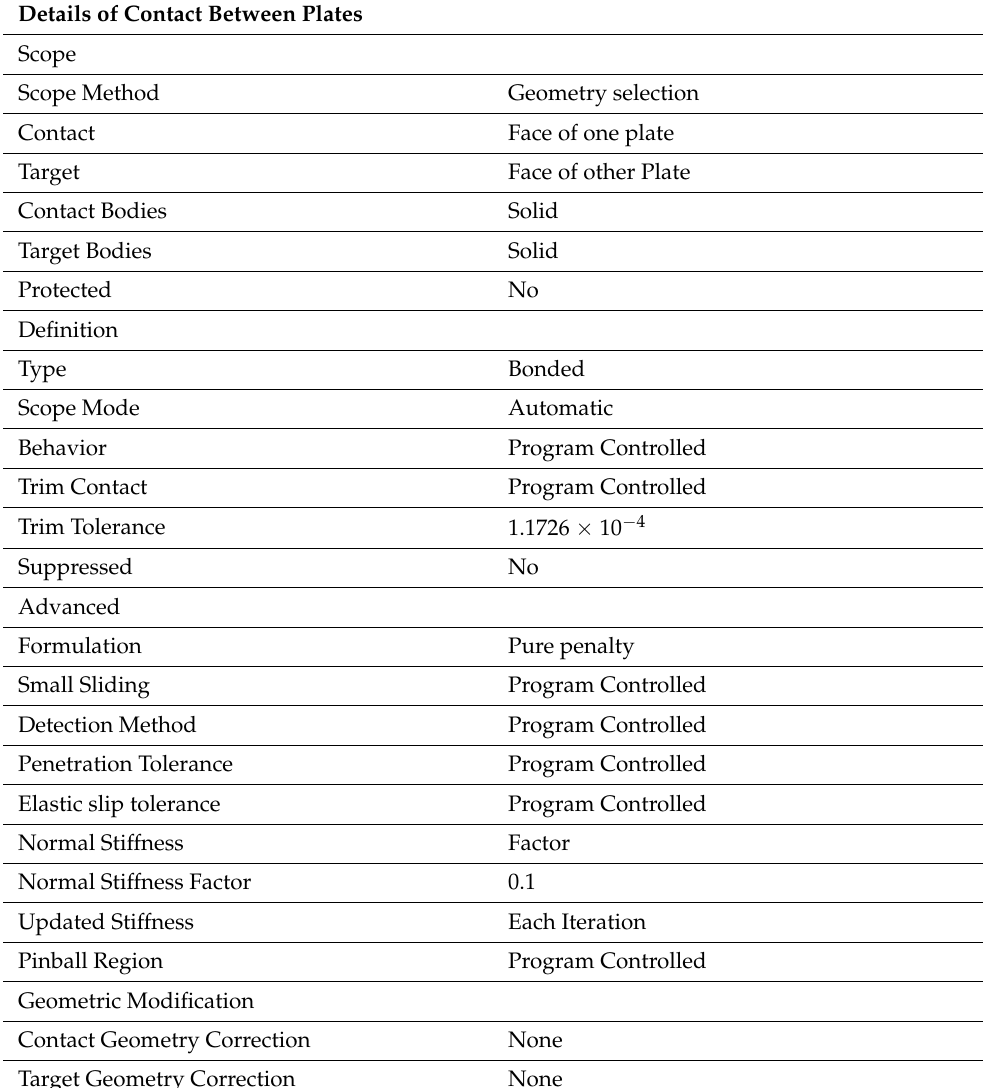
Table 4. Details of contact between plates.